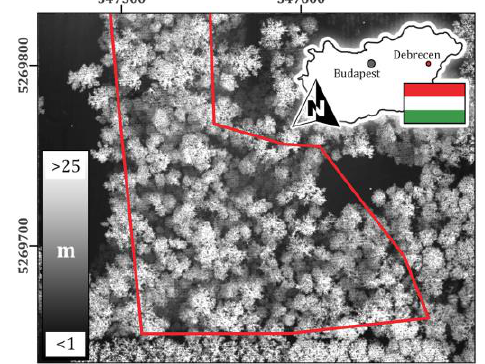
Figure 1: nDSM of Natura 2000 study site (red borderline) in Eastern